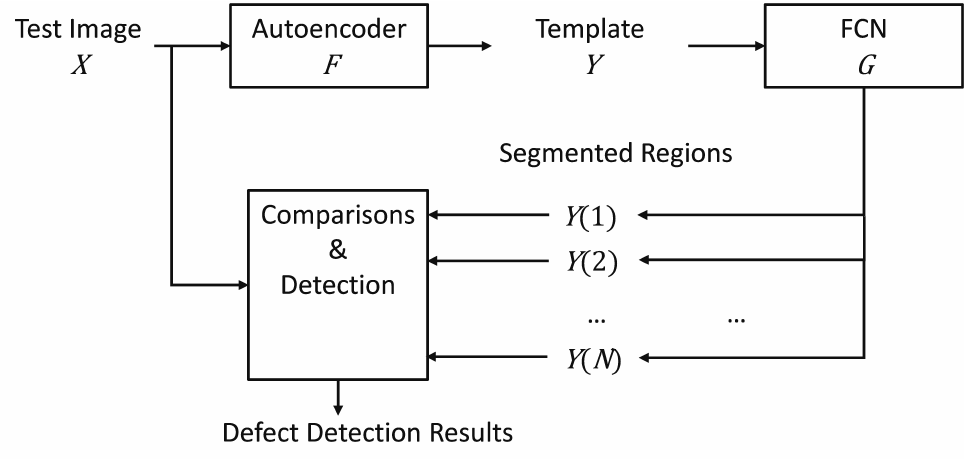
Figure 2. The overview of the proposed quality inspection of surface